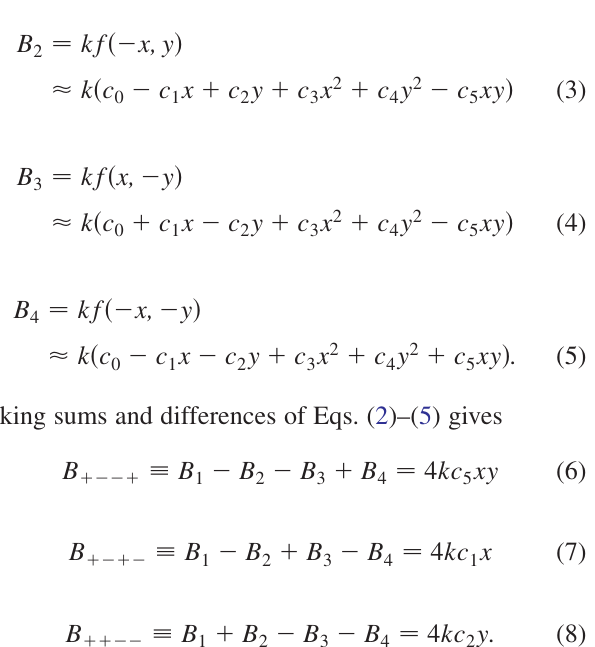
FIG. 3. B þ(cid:3)(cid:3)þ versus distance ( the